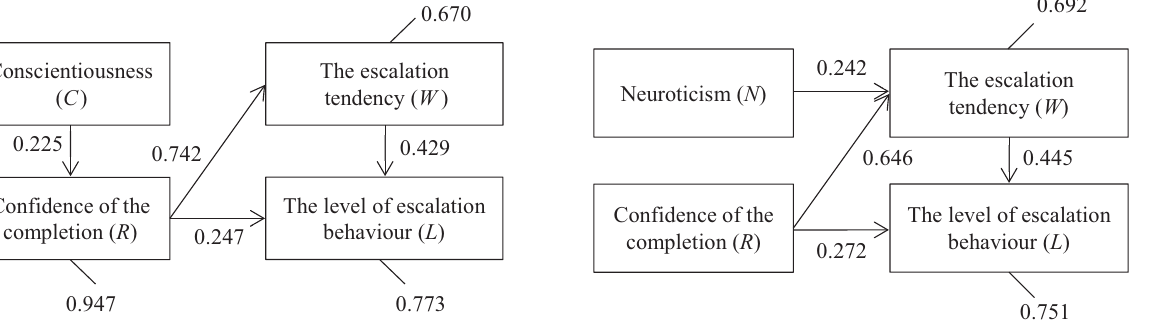
Figure 4. EOC model in Scenario III